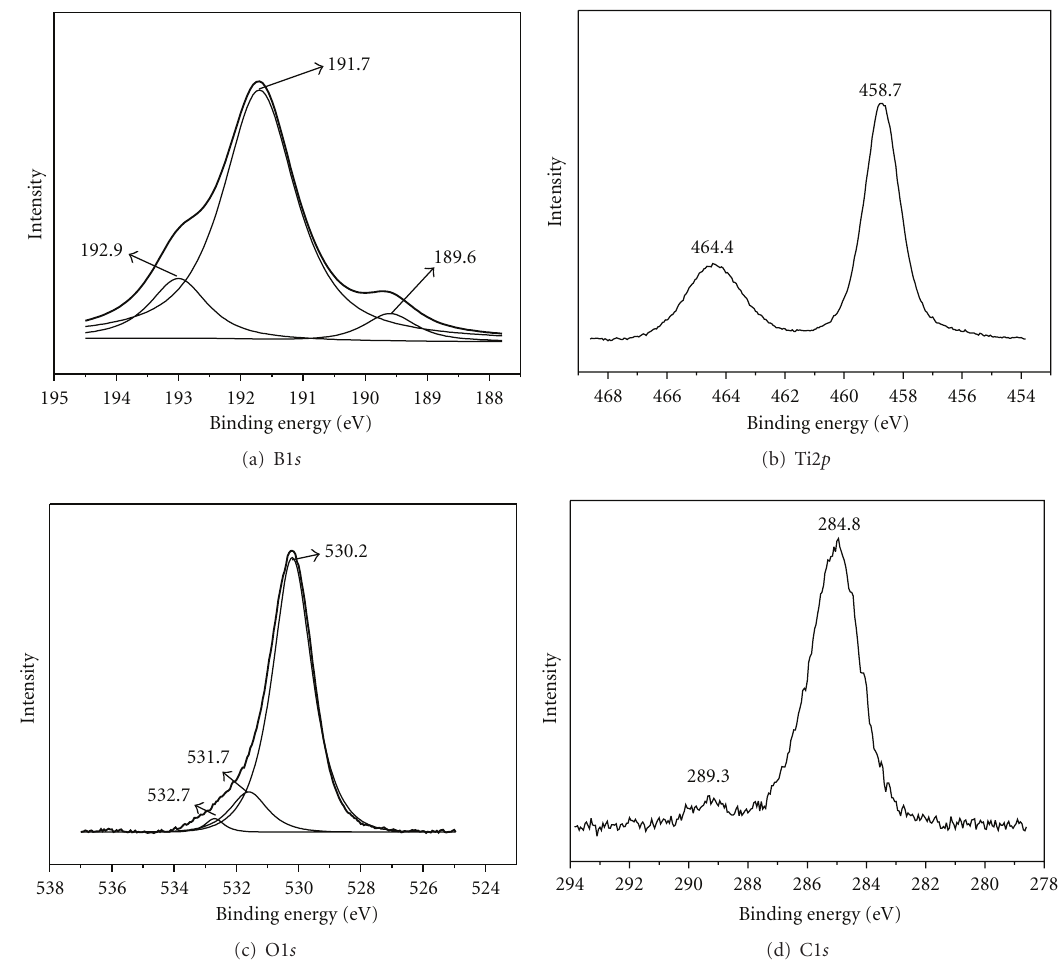
Figure 4: XPS patterns of 3% B-TiO 2 sample calcinated at 400 ◦ C.